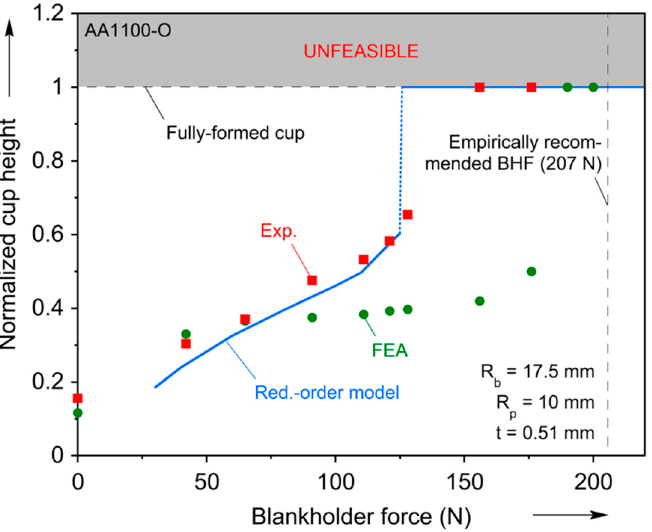
Figure 15. Normalized cup height at the onset of flange wrinkling for different BHFs, including experimental results and predictions from the reduced-order model and finite element model.